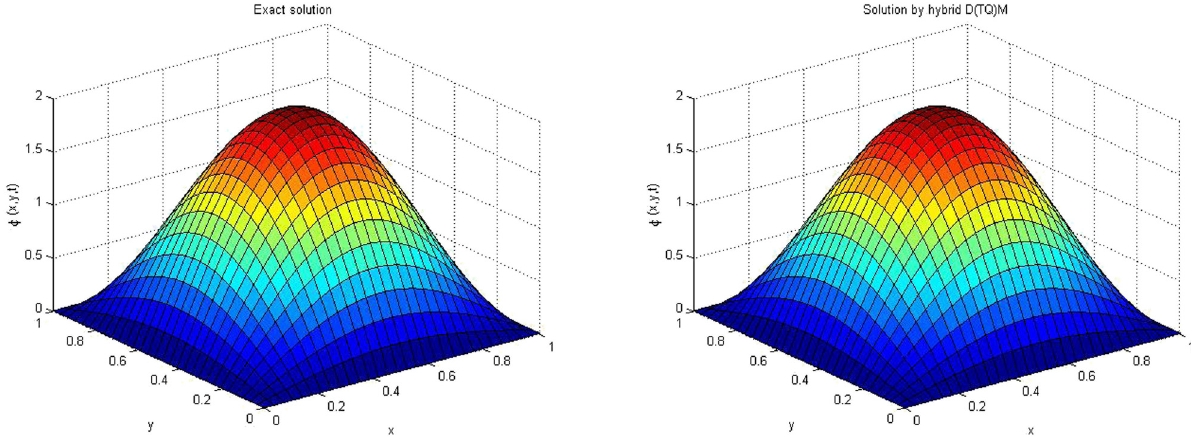
Figure 1: Comparison of exact solution and solution due to D ( TQ ) M of the di ff usion equation of Example 4.1 with M N 30 = = , ρ 0.4 = , and T = 1.